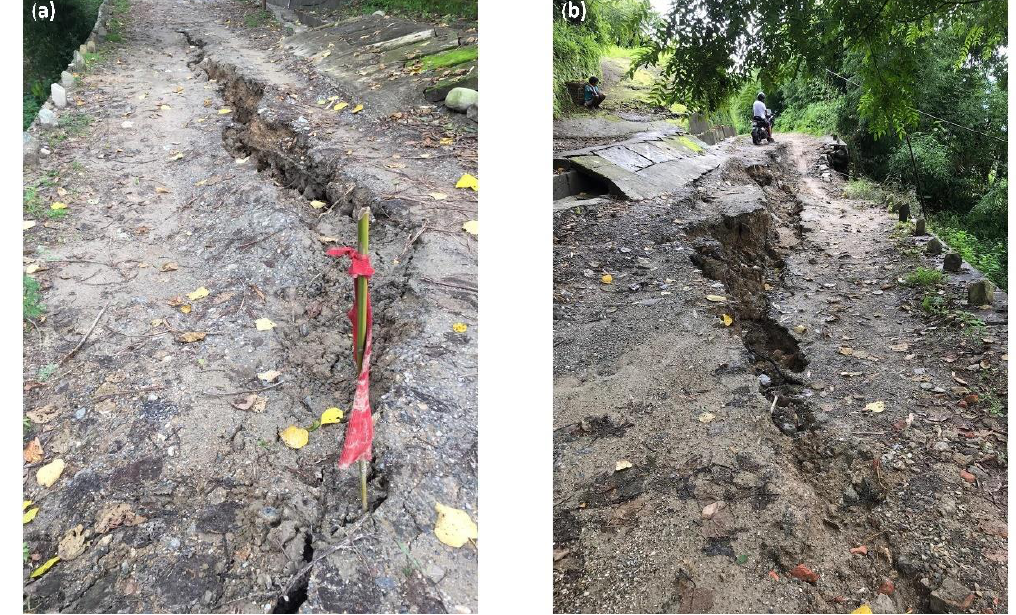
Figure 8. Cracks developed in road near Pyarienii jhora during 2020 monsoon ( a ) on 27 July 2020 and ( b ) on 6 August 2020.